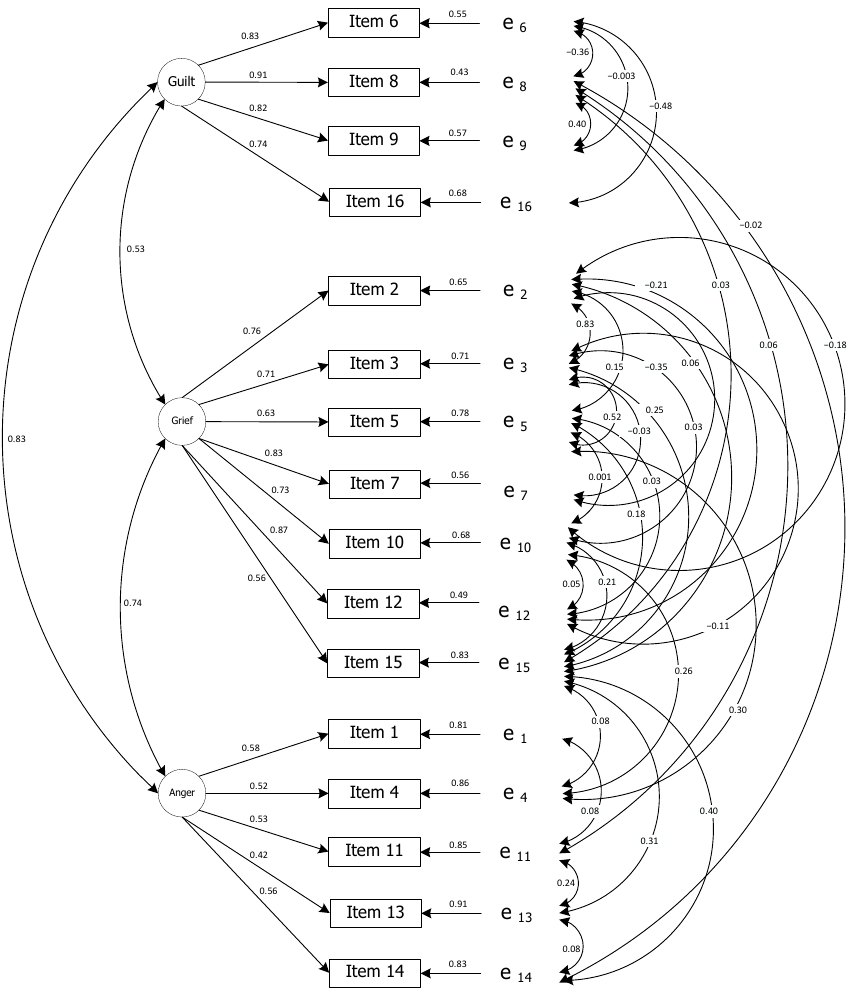
Figure 1. Factor loadings of confirmatory factor analysis for the Portuguese version of the PBQ (Standardized Parameters Estimates) and residual errors (e 1 to e 16